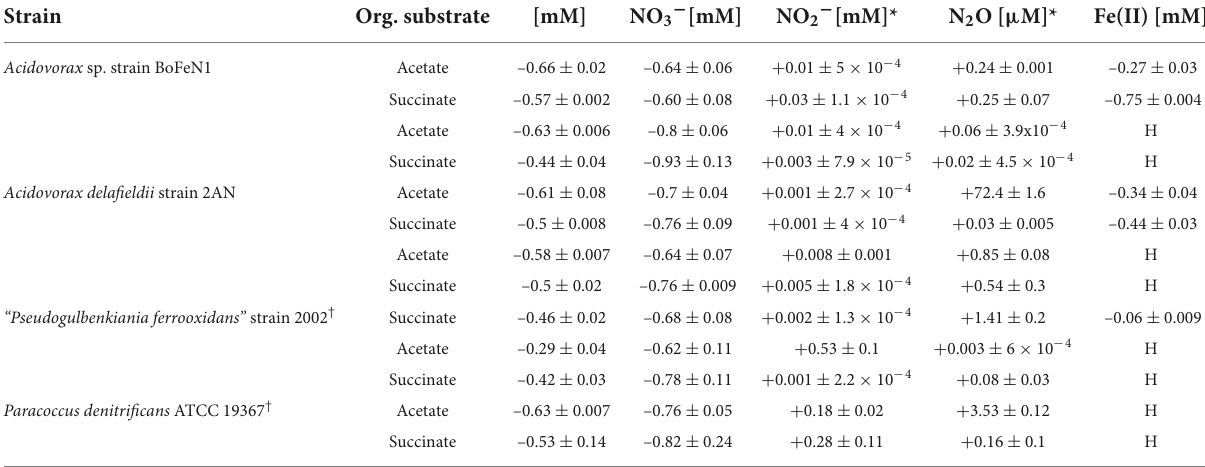
TABLE 1 Nitrate-based experiments in the presence and absence of Fe(II); – for reduction, + for production. Strain